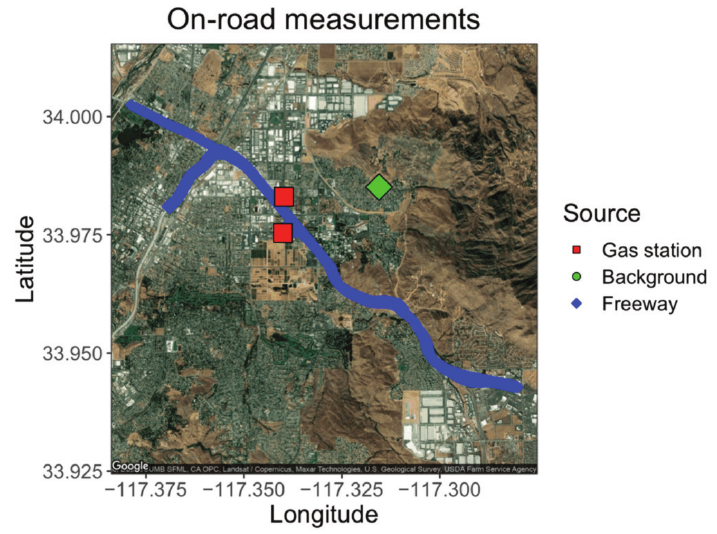
Figure 9. Map of freeway route on SR 60 with targeted gas stations and the local background measured 6.5 km east of the SR 60.